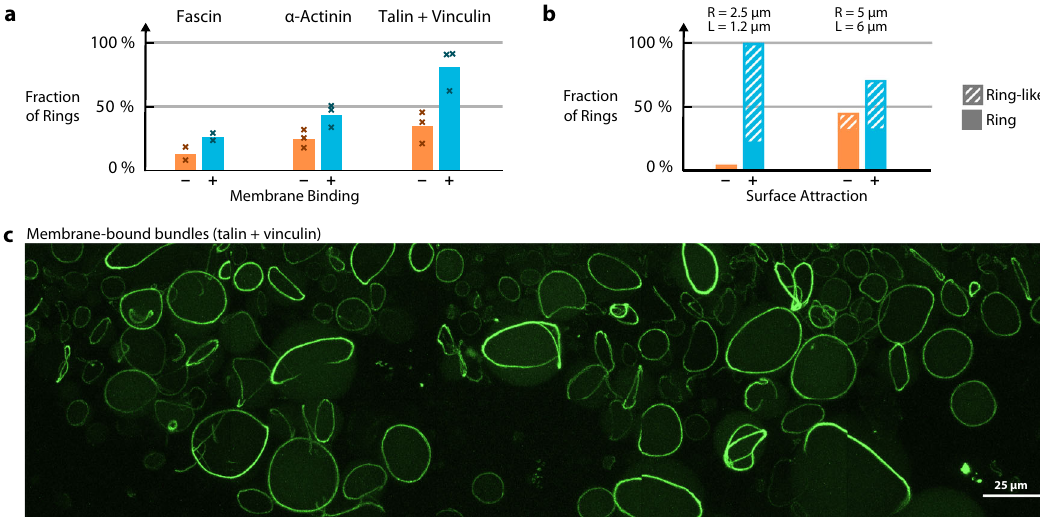
Fig. 4 Formation of membrane-anchored actin rings. a Membrane-binding promotes ring formation. Shown is the probability of the formation of single actin rings in GUVs (i.e., GUVs with one single unbranched actin bundle connected into a ring) in the absence or presence of membrane-anchoring. Data are shown as mean values with individual fractions of experimental runs. Three hundred ninety two vesicles between 15 and 20 µ m were analyzed in n = 2 (fascin) or n = 3 experimental runs per condition. We use 2 µ M actin in all cases, but due to differences in bundling activity different concentrations of bundling protein: 0.3 µ M fascin, 1 µ M α -actinin, 2 µ M talin, and 2 µ M vinculin. b Probability of ring formation for simulations with different initial parameters ( R : vesicle radius, L : fi lament lengths). In simulations, we classi fi ed rings with small gaps or closed rings with additional side branches as “ ring like ”